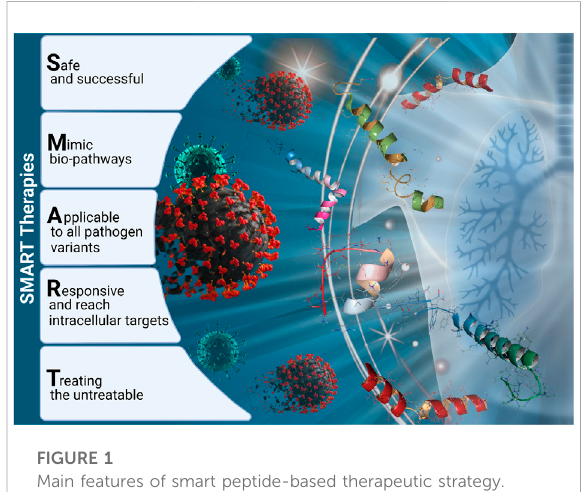
Main features of smart peptide-based therapeutic